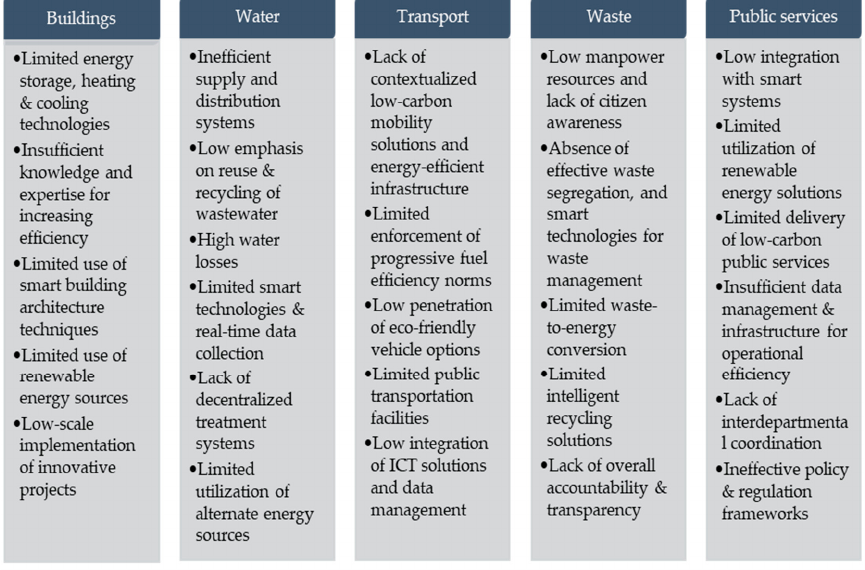
Figure 2. Challenges for SEM solutions in different sectors.